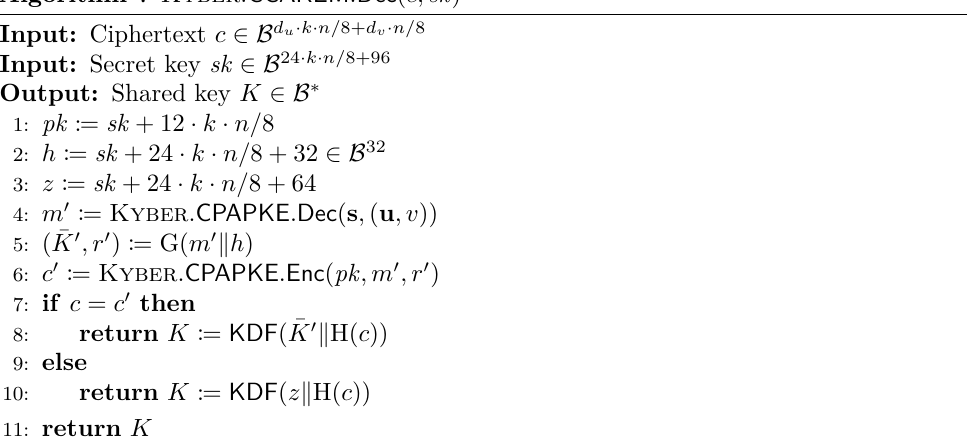
Algorithm 7 Kyber . CCAKEM . Dec ( c, sk